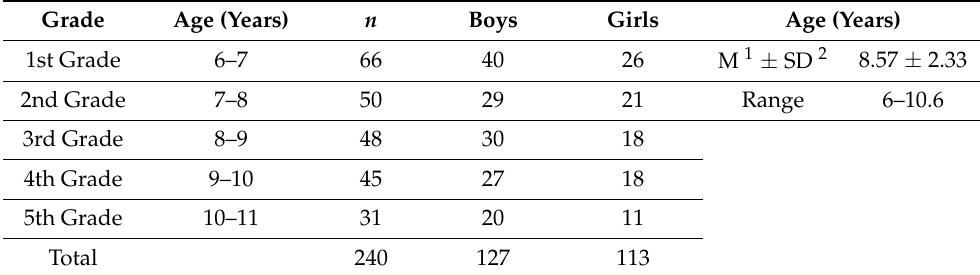
Table 1. Characteristics of the participants.